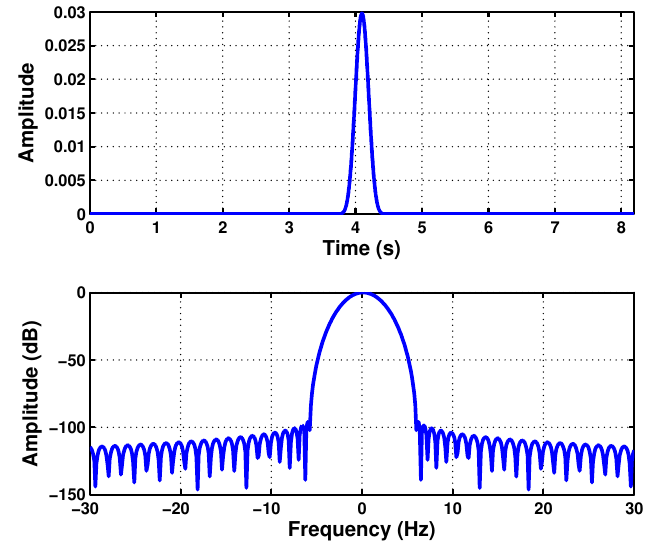
Figure 12. Slepian window ( B W = 11.55 Hz, T W = 692.8 ms), optimized for detecting the LSH during the start-up of the high-power, high-voltage IM given in Appendix B, represented in the time ( top ) and in the frequency ( bottom ) domains.